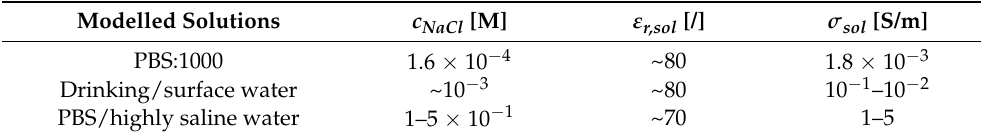
Table 1. Modelling of the electrical properties at 20 ◦ C of real aqueous samples and biological buffers using saline solutions at different concentrations. Mean concentrations and, therefore, dielectric properties are considered as the physico-chemical content of the water samples can vary from place to place [34,35]. Modelled